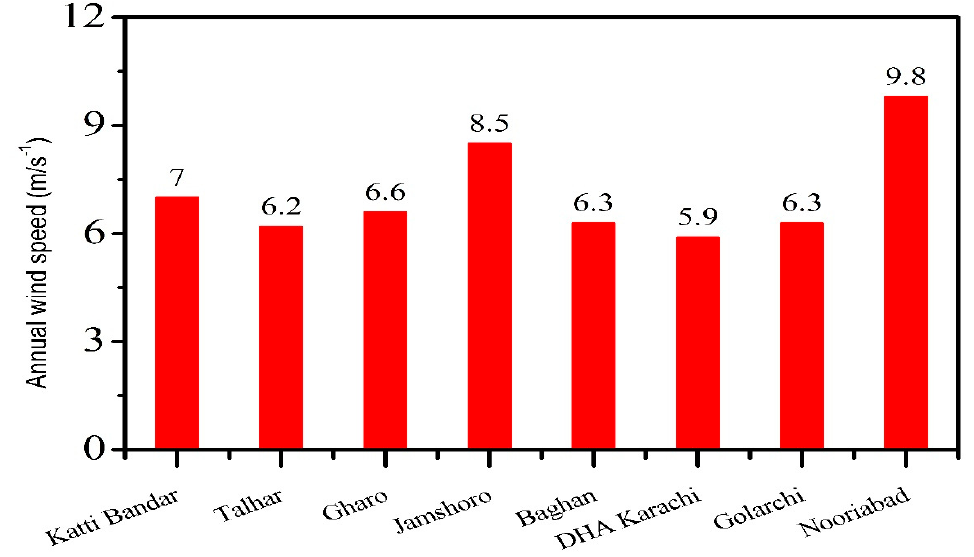
Figure 3. Annual mean wind-speed ms − 1 .